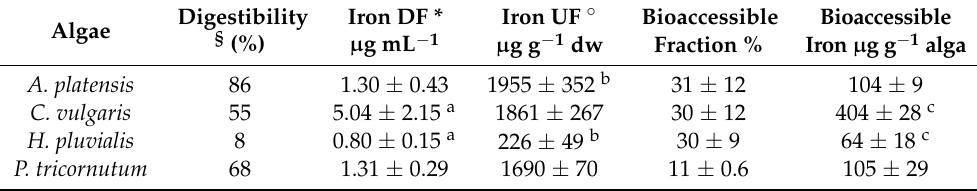
Table 1. The iron content in algal biomass, digestibility and bioaccessibility in four